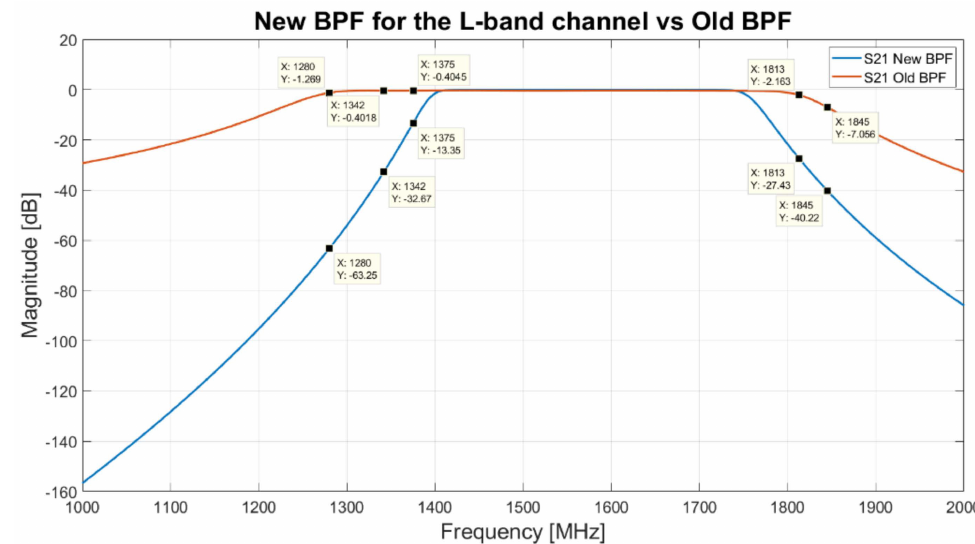
Figure 15. Comparison between the S21 parameter of the old L-band BPF (red curve), centered at 1540 MHz with a bandwidth of 520 MHz (model 5B120-1540/T520-O/O from K&L) and the new ideal BPF (blue curve). It has a − 3 dB bandwidth between 1400 and 1750